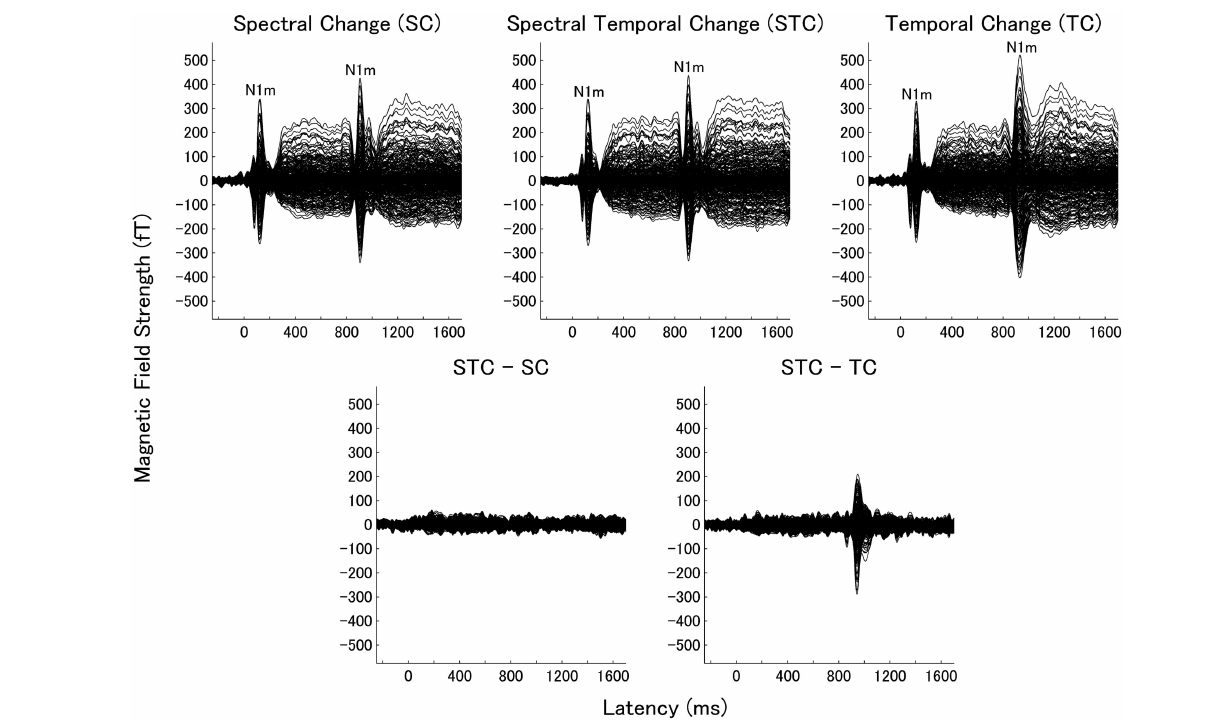
FIGURE 3 | Examples of individual magnetic waveforms of all sensors in experiment 1. The upper panels represent the auditory evoked fields of one representative subject elicited by the spectral change (SC: left),